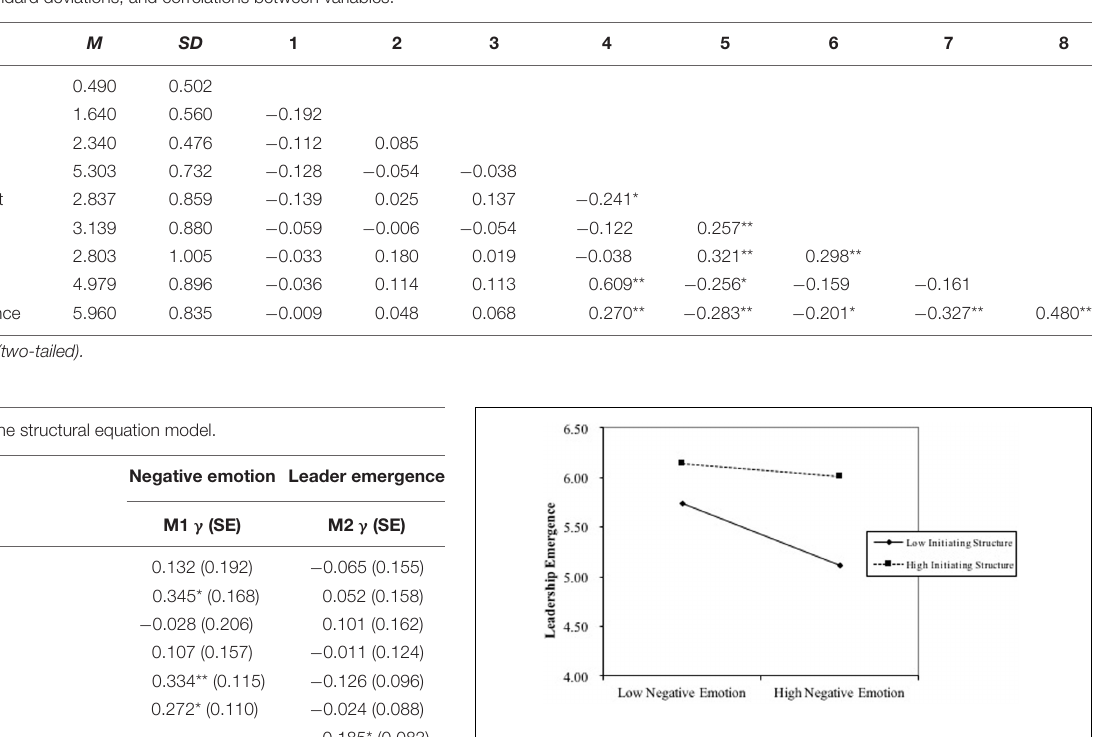
FIGURE 2 | Moderating effect of initiating structure on the negative emotion–leadership emergence relationship.